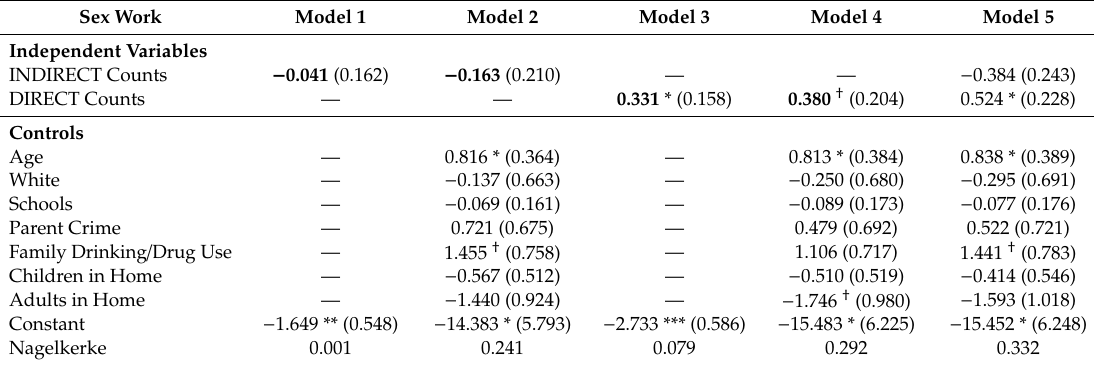
Table 5. The e ff ect of indirect and direct victimization counts on sex